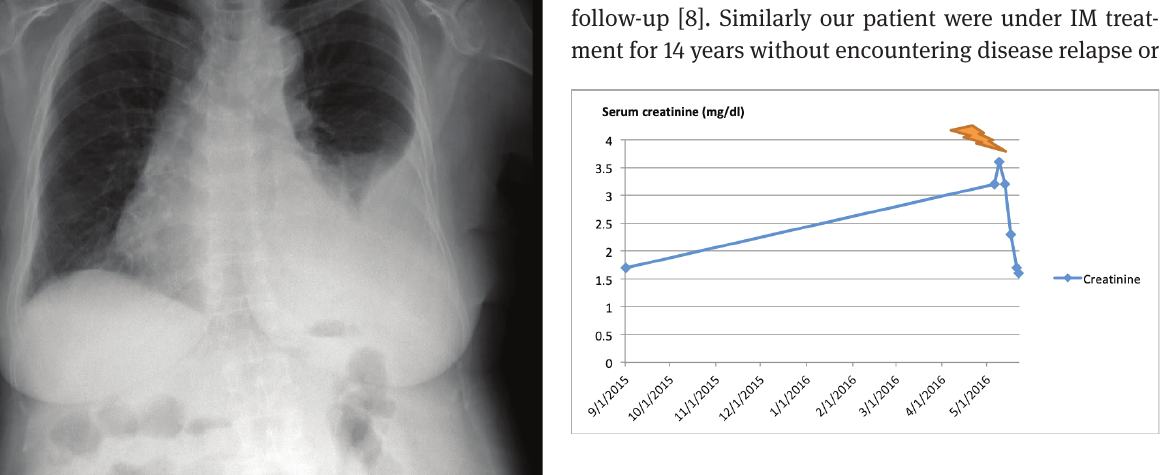
Discontinuation of imatinib